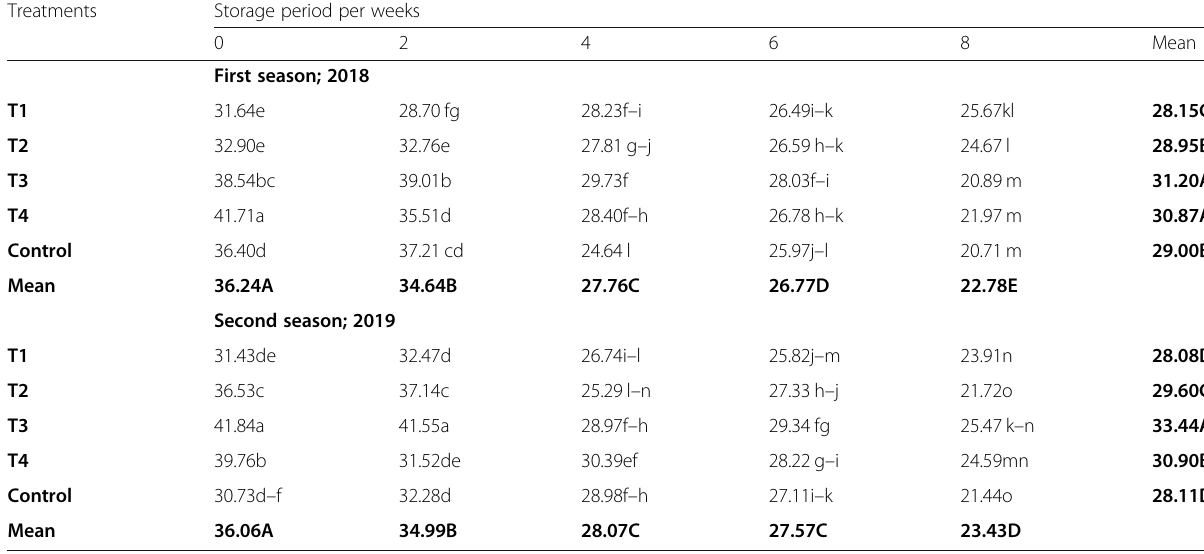
Table 3 Effect of preharvest spraying with moringa leaf extract, boric acid, and chelated calcium on L* of Hollywood plum fruits stored at 0 ± 1 °C and RH 85 – 90% during 2018 and 2019 seasons Treatments